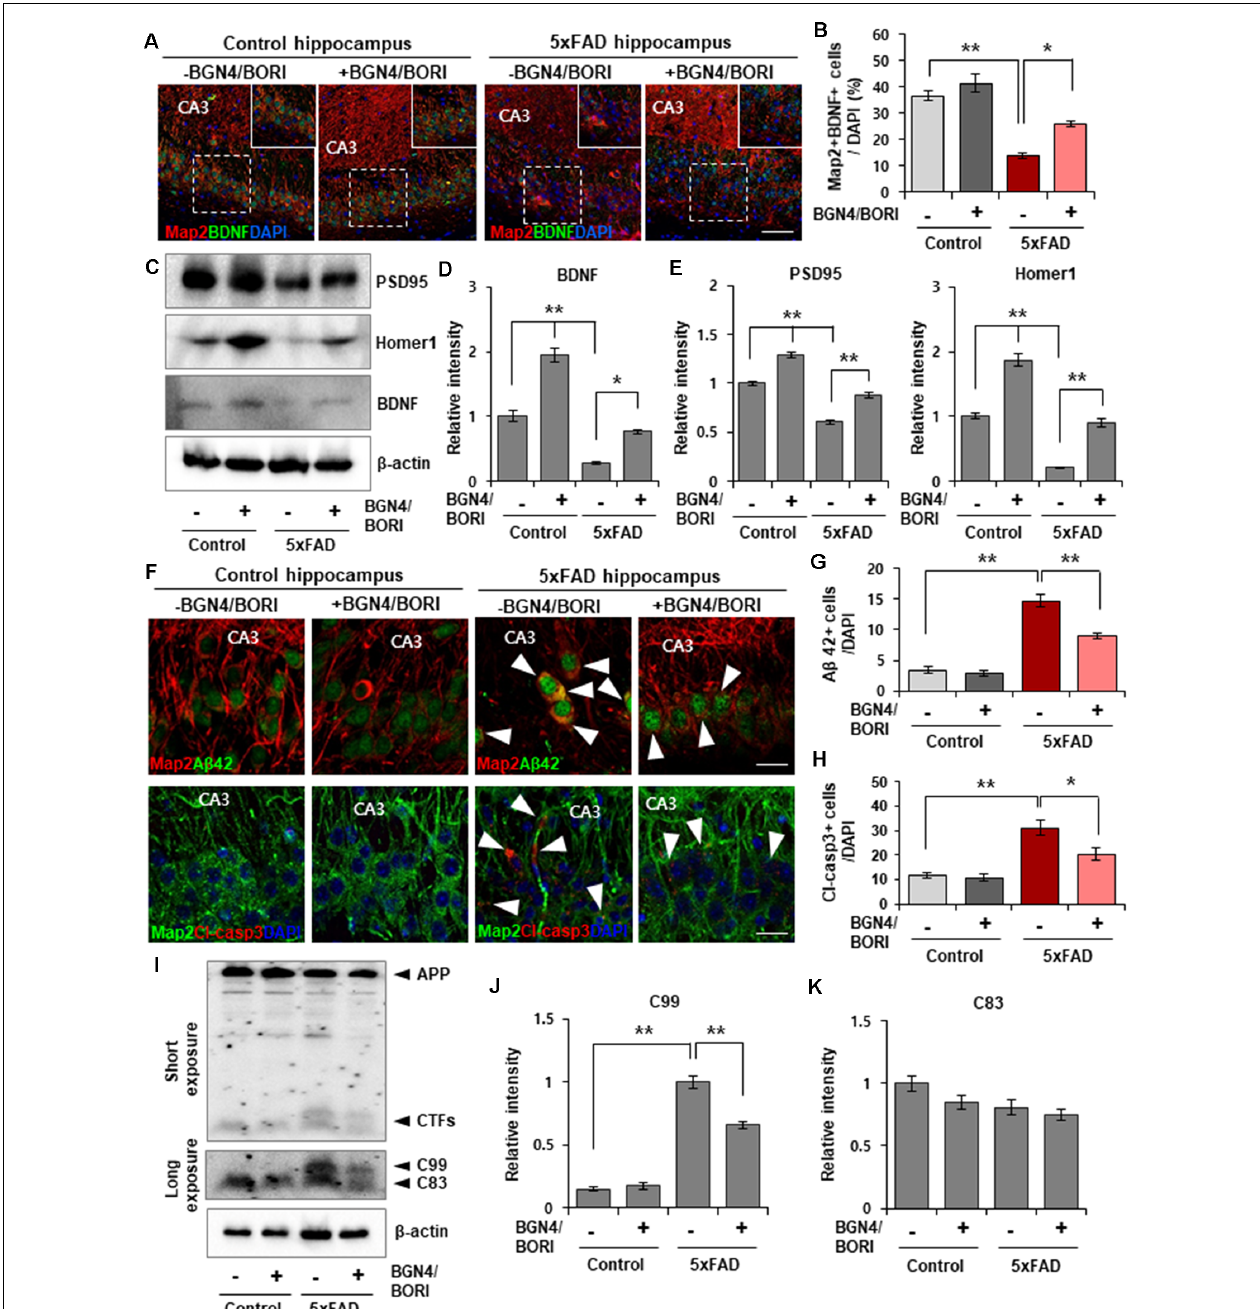
FIGURE 2 | B. bifidum BGN4 and B. longum BORI reduced Alzheimer’s disease (AD) pathogenesis in the 5xFAD Mouse Brain. (A) Representative images of Map2 and BDNF positive cells in the CA3 hippocampal subfields of control or 5xFAD mice treated with B. bifidum BGN4 and B. longum BORI (BGN4/BORI). Scale bar = 50 µ m. (B) Quantification of the Map2+/BDNF+ neurons in the CA3 hippocampal region at 30 days. Data represent the mean ± SEM. ANOVA , * p < 0.05, ** p < 0.01 ( n = 5). (C) Western blot analysis of the scaffolding proteins, PSD95 and Homer1, and blood brain-derived neurotrophic factor, BDNF, in the hippocampus of control or 5xFAD mice treated with B. bifidum BGN4 and B. longum BORI. (D) Hippocampal quantification of BDNF expression were normalized to β -actin. Data represent the mean ± SEM. ANOVA , * p < 0.05, ** p < 0.01 ( n = 5). (E) Hippocampal quantifications of PSD95 (left) and Homer1 (right) expression were normalized to β -actin. Data represent the mean ± SEM. ANOVA , ** p < 0.01 ( n = 5). (F) Representative images showing the production of amyloid- β 42 (top) and cleaved-caspase3 (bottom) in the CA3 hippocampal subfields of control or 5xFAD mice treated with B. bifidum BGN4 and B. longum BORI. Scale bar = 20 µ m. (G,H) Quantifications of the amyloid- β 42+ (G) and cleaved-caspase3+ (H) cells in the CA3 hippocampal region at 30 days. Data represent the mean ± SEM. ANOVA , * p < 0.05, ** p < 0.01 ( n = 6). (I) Immunodetection of amyloid precursor protein (APP), C99, C83 in Western blots with protein lysates derived from the hippocampus. (J,K) Hippocampal quantifications of C99 (J) and C83 (K) expression were normalized to β -actin. Data represent the mean ± SEM. ANOVA , ** p < 0.01 ( n = 5).